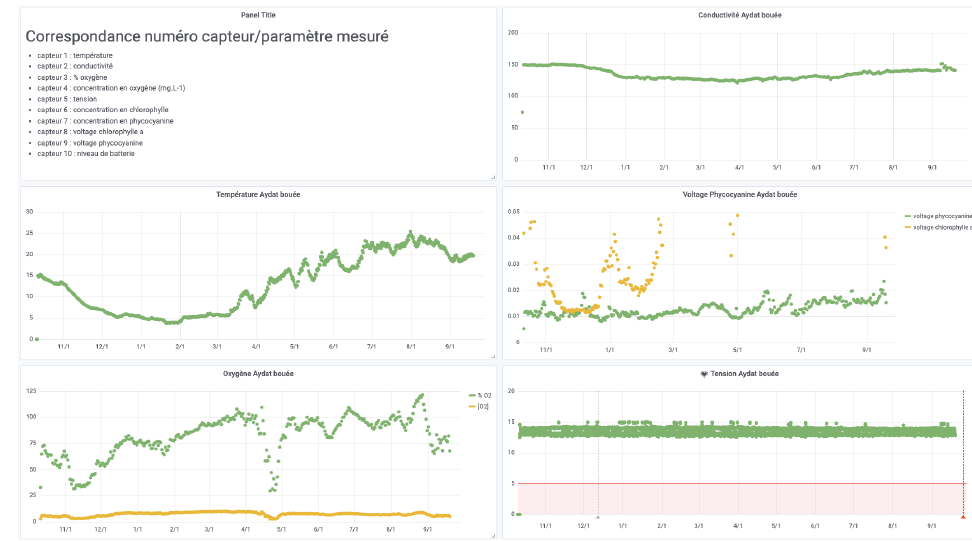
Figure 11. Extract of the dashboard of one system—courtesy of Aydat